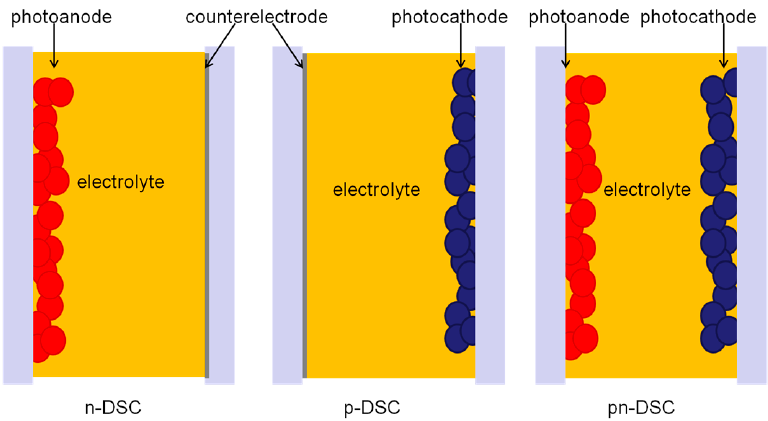
Figure 1. Structure of n-DSC, p-DSC and pn-DSC.